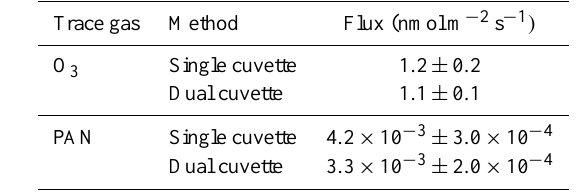
Table 6. Comparison of O 3 and PAN flux between a single-cuvette and dual cuvette measurement